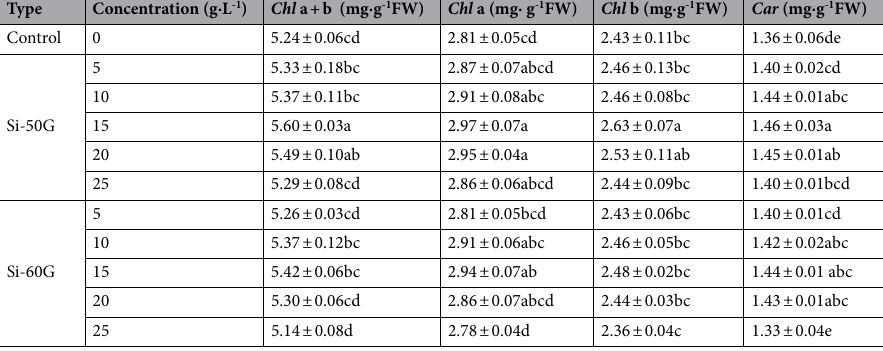
Table 3. Effects of Si (5, 10, 15, 20, and 25 g·L −1 ) on the photosynthetic pigment contents. The values represent the mean ± SE (n = 4). Values with the same letters in the columns are not significantly different at P < 0.05.